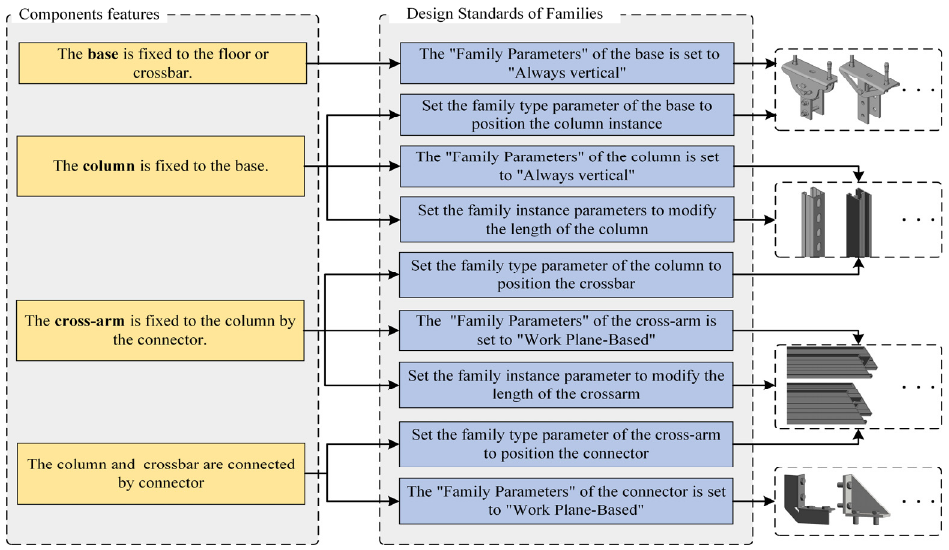
Figure 4. Relationships between the component features and the design standards of families.